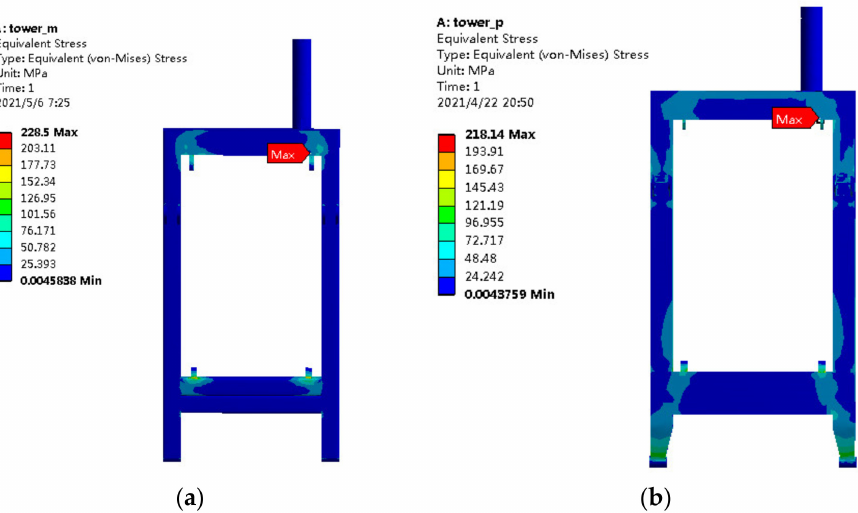
Figure 17. Stress distribution during the vertical laying of the tower. ( a ) Scaled model; ( b ) prototype.